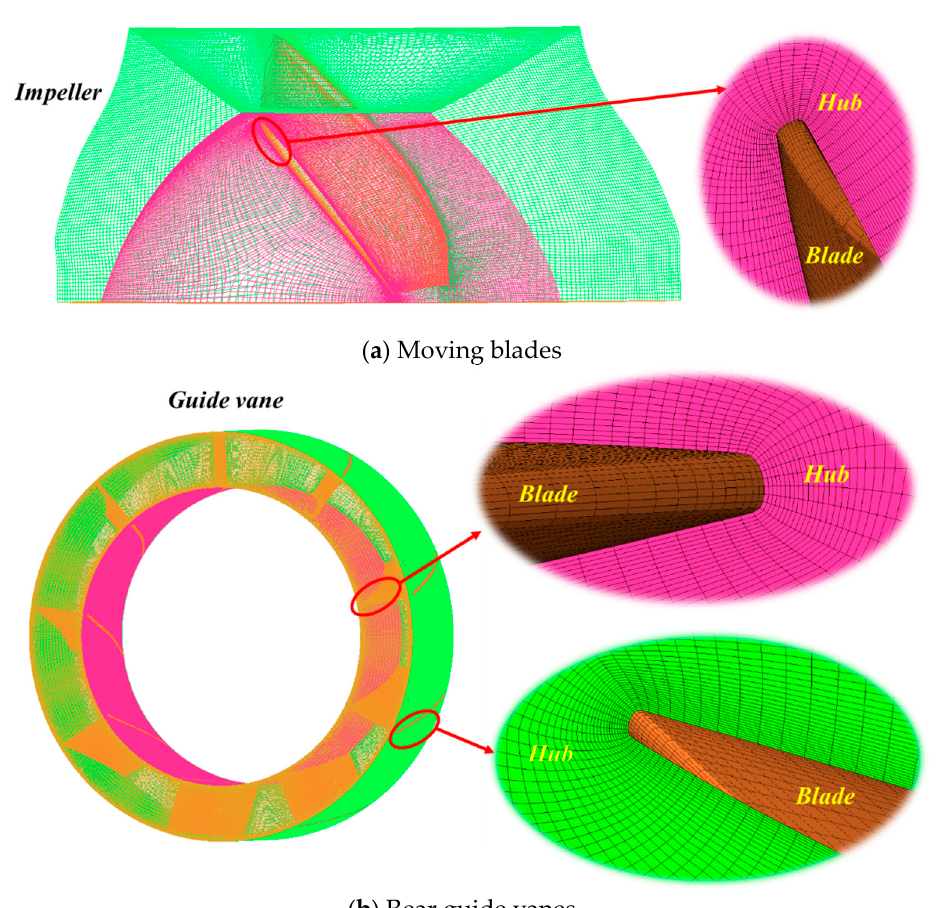
Figure 5. A computational grid model.